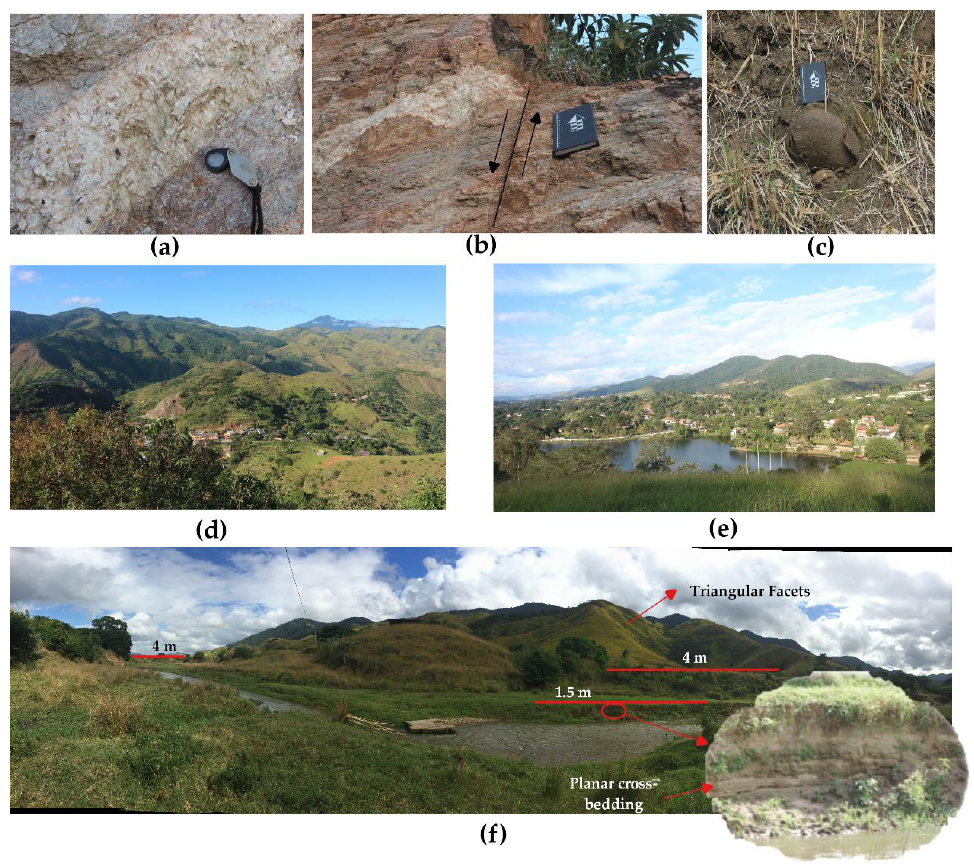
Figure 10. Examples of sites of geological interest in Miguel Pereira municipality: ( a , b ) mylonitised rock associated with the Central Tectonic Boundary (CTB) showing in ( a ) concordant pegmatite and in ( b ) subvertical normal fault; ( c ) diabase dyke with spheroidal exfoliation; ( d ) viewpoint where it is possible to observe triangular facets, hills, and the Santana River valley; ( e ) viewpoint at Javary Lake; ( f ) fluvial terraces with two different levels (4 m and 1.5 m), triangular facets, and planar cross-bedding at the edge of the terrace. Table 3. Pearson’s correlation coefficient results using the geodiversity index map, vegetation, land-use, and sites of geological interest in Miguel Pereira